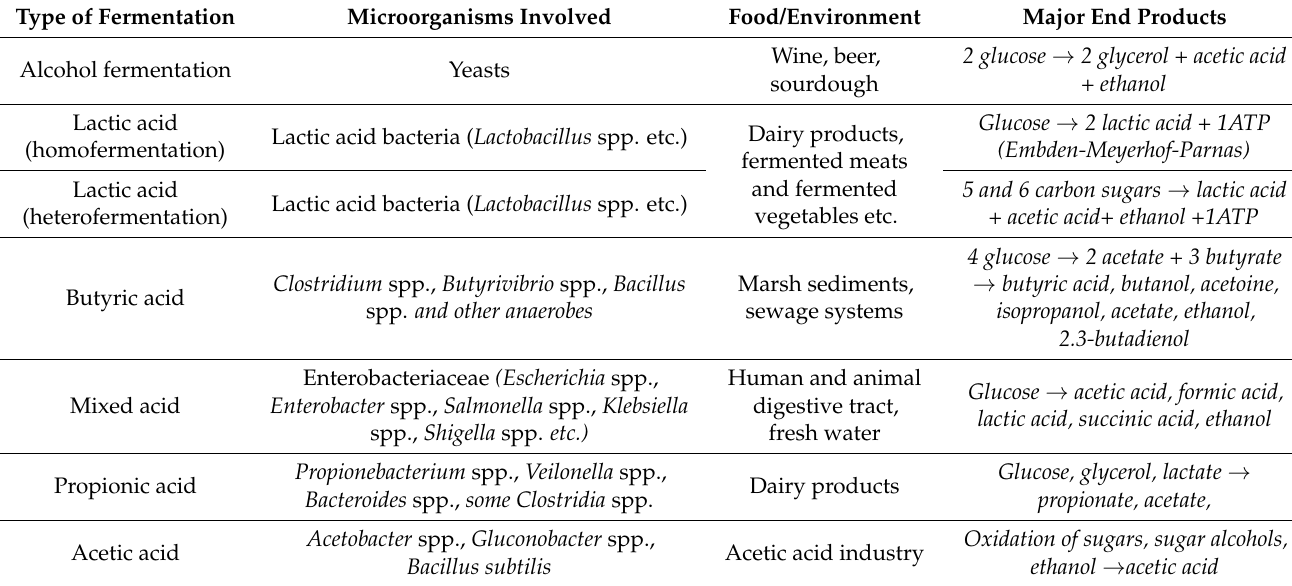
Figure 1. The diversity of fermentations. One molecule of glucose through glycolysis results in two molecules of pyruvate. Under anaerobic conditions and depending on the microorganism involved, fermentation can continue in certain pathways. Table 1. Most common fermentations and the implicated